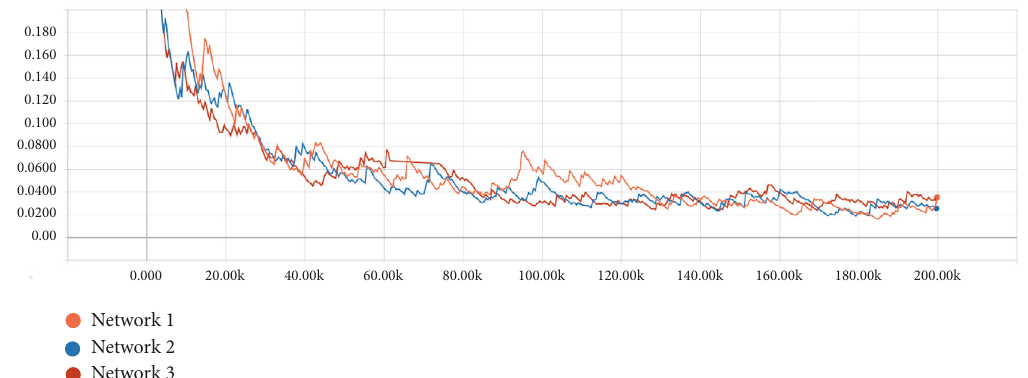
Figure 4: First trainings of CNN maintaining coefficients with different datasets.